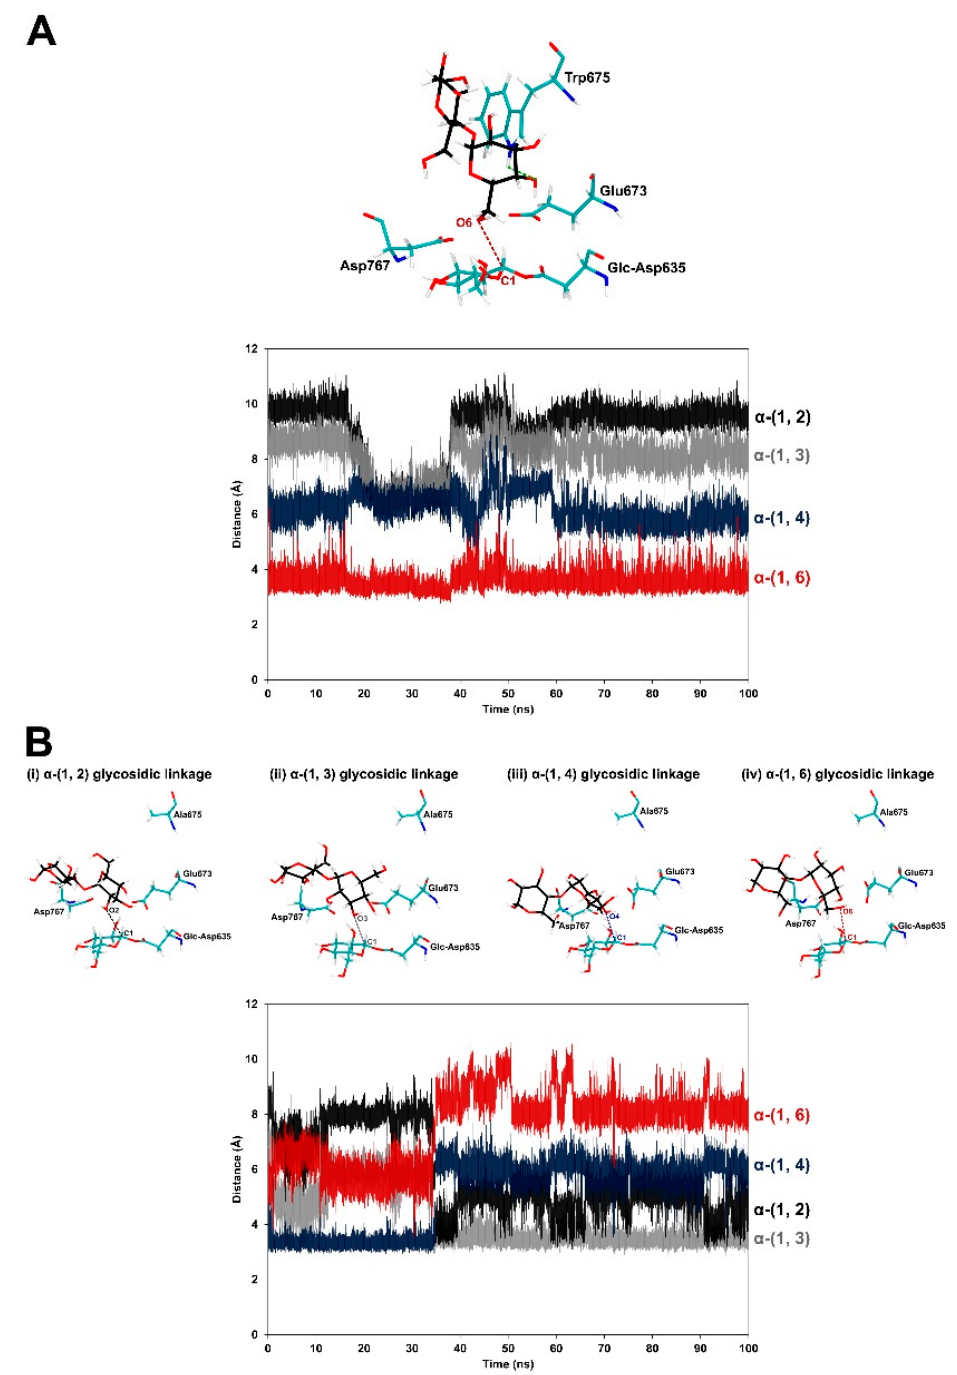
Figure 7. The proximity between atoms necessary for transglycosylation and hydrogen bond interaction of ( A ) maltose- ALT wt and ( B ) maltose-ALT W675A complexes. The distances between O2, O3, O4, O6 of the nonreducing terminal glucose of maltose and the C1 atom of the glc-D635 intermediate are shown in black, grey, blue, and red, respectively. Hydrogen bond interactions are represented with a green dashed line.